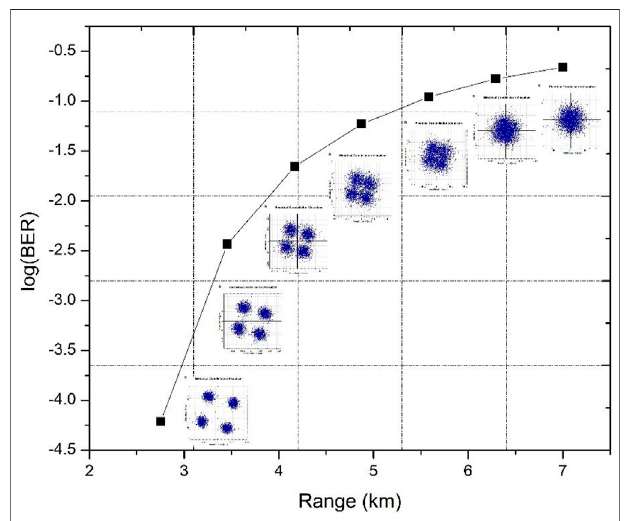
FIGURE 4 | log(BER) vs. range under different rain intensities for OFDM/ SAC-OCDMA-FSO.